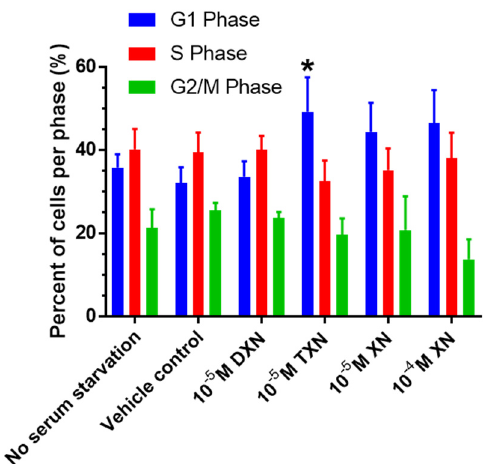
Figure 5. Cell cycle analysis using HT29 cells and propidium iodide, values are mean ± SD, n = 9 for each treatment. An asterisk indicates a statistically significant difference from vehicle control ( p < 0.05). Statistical analysis was performed using one-way ANOVA with a Sidak’s post hoc test.